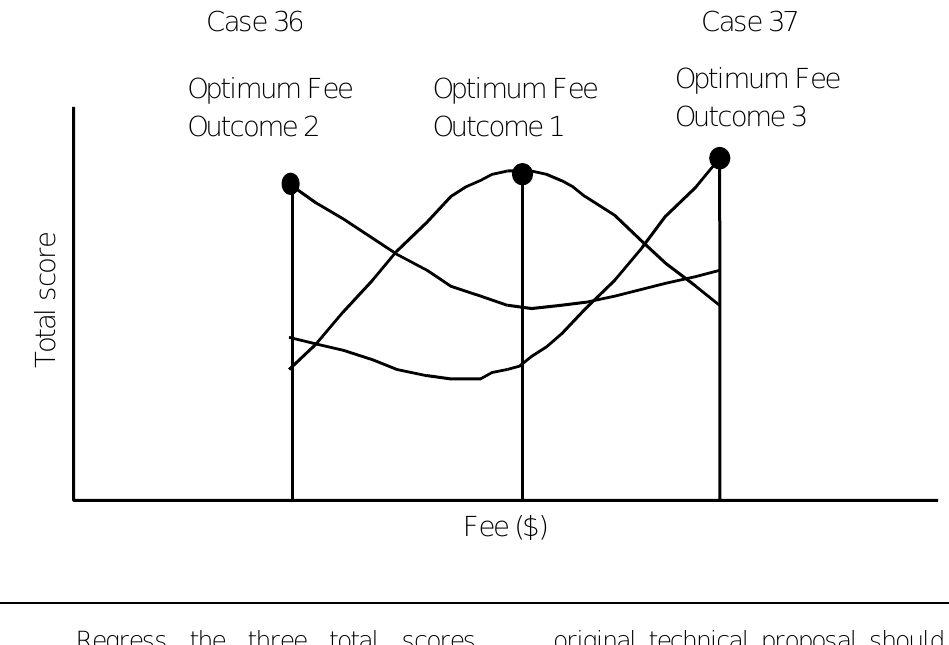
Figure 2: Possible optimum fee outcomes (Source: Drew et al.